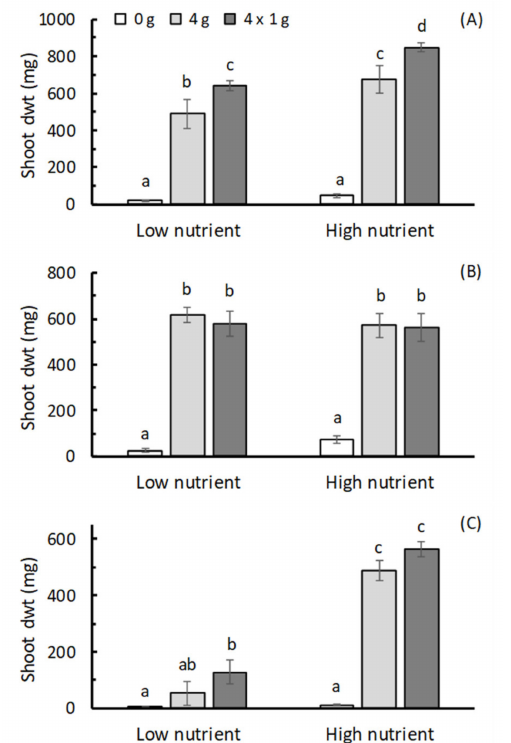
Figure 1. Effects of adding HexaFrass™ at rates of 0 g, 4 g and a 4 × 1 g split application on the shoot dry wt (mean ± se; n = 4) of ( A ) basil, ( B ) lettuce and ( C ) parsley seedlings in low and high nutrient potting mix. For each plant, treatments sharing the same letter code deemed not to be significantly different using LSD obtained from ANOVA at p < 0.05.